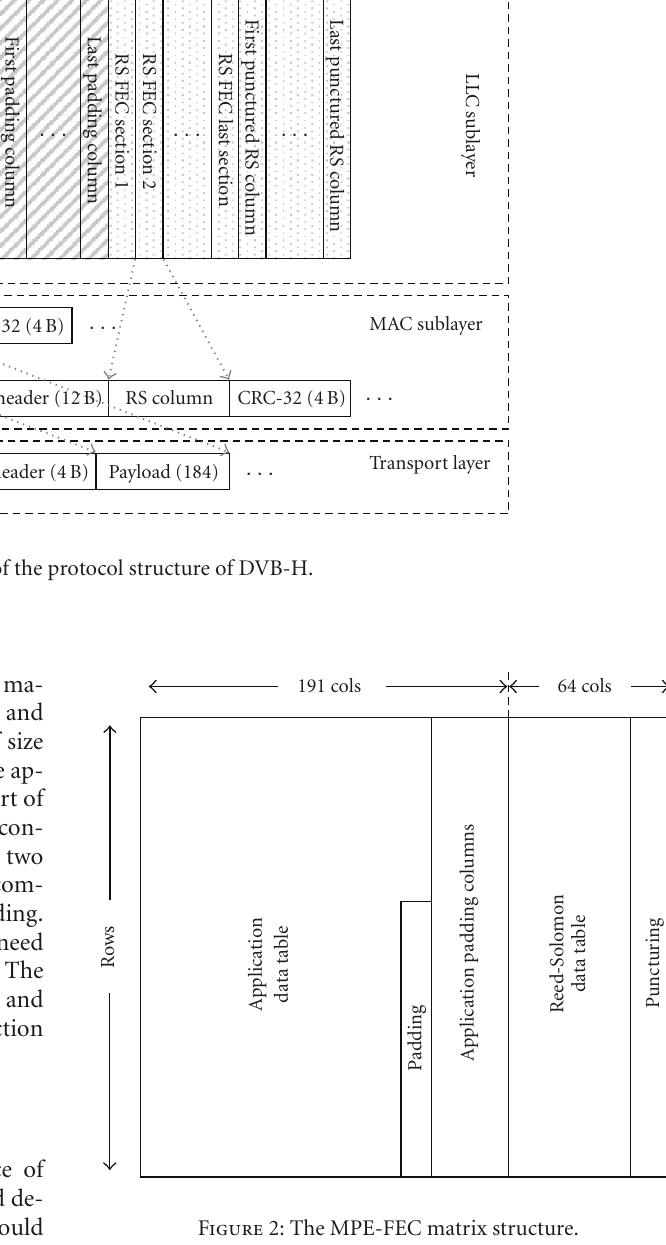
Figure 2: The MPE-FEC matrix